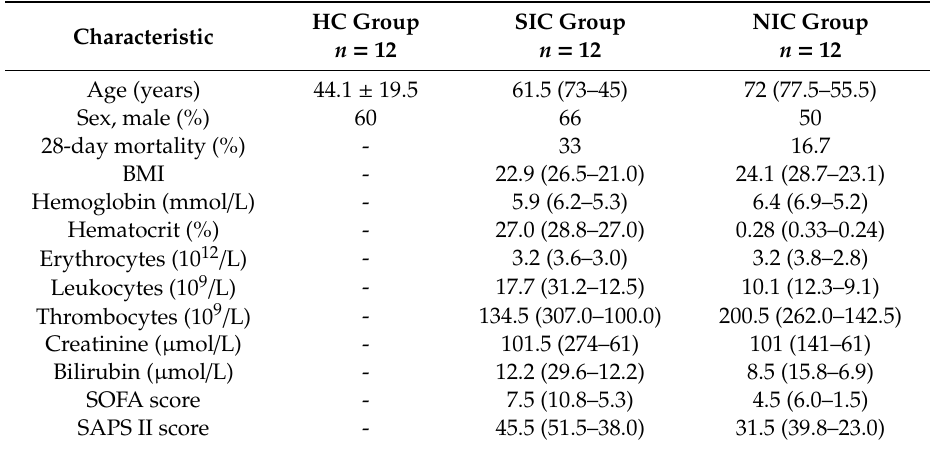
Table 1. Epidemiological, clinical,